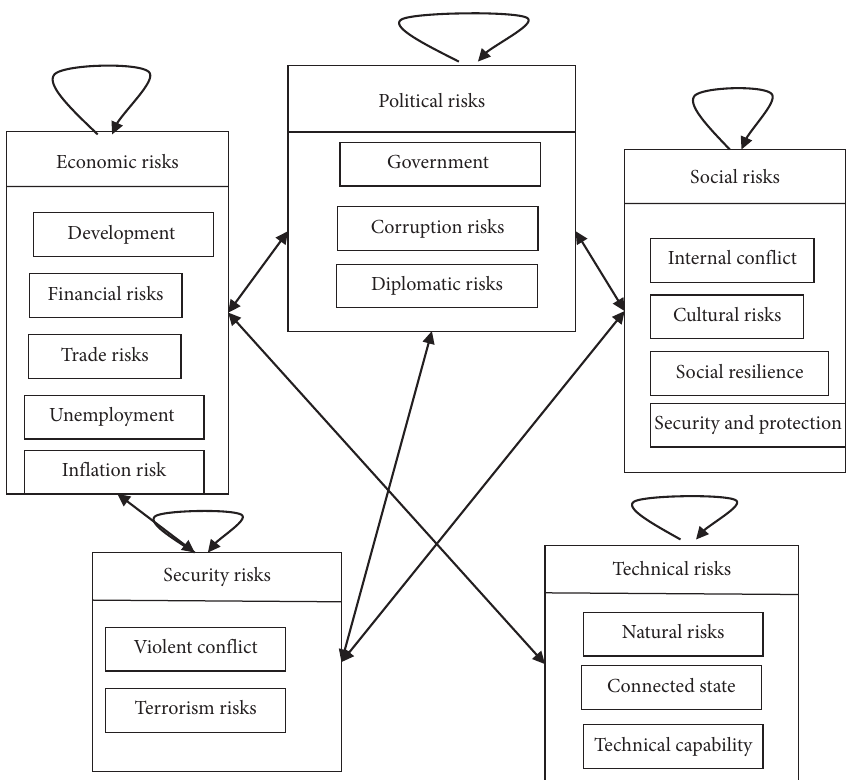
Figure 1: International transportation corridor’s operational risk network